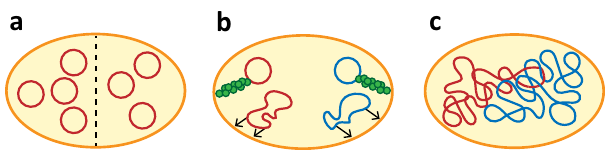
Fig. 3 Synthetic DNA segregation mechanisms. a Random partitioning of DNA molecules, generating viable offspring in synthetic cells with suf fi ciently high genome copy numbers. b Molecular machineries for active partitioning of DNA molecules, such as the Par system (top) or membrane anchors in elongating cells (bottom). c Entropy-driven segregation, relying on the physical behaviour that large overlapping DNA macromolecules constrained in a small volume will spontaneously get separated from each